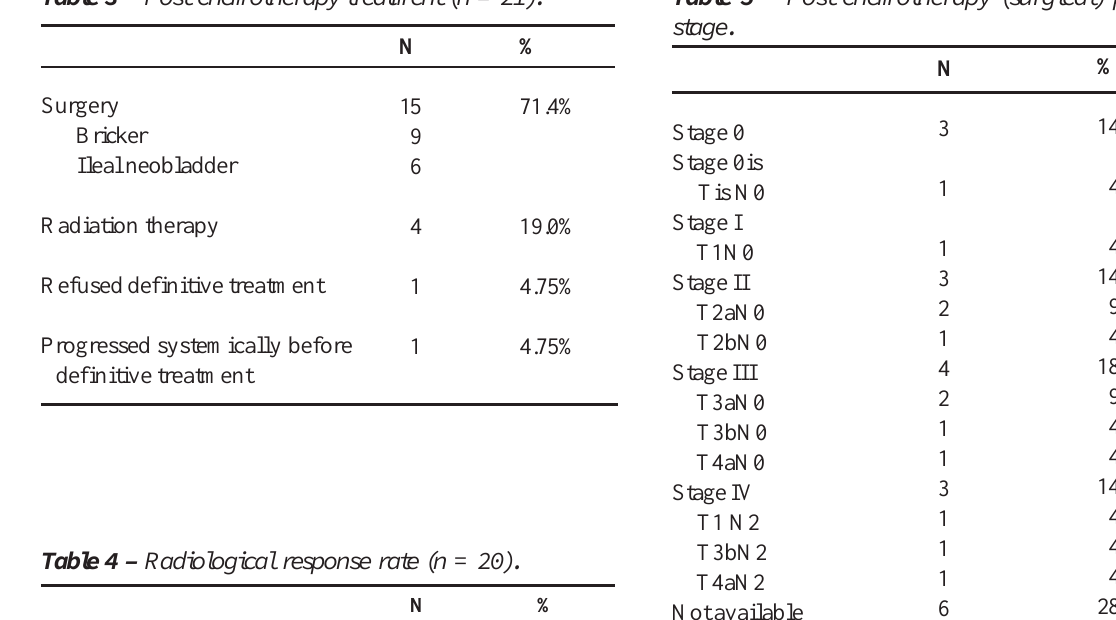
Table 3 – Post-chemotherapy treatment (n = 21).